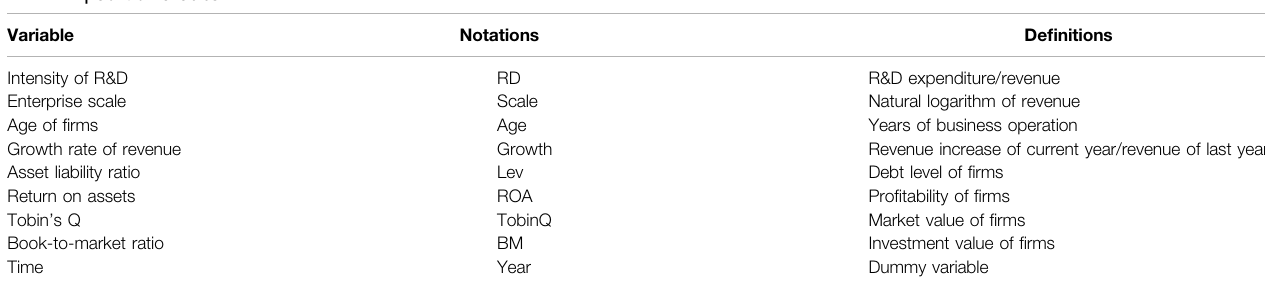
TABLE 2 | Control